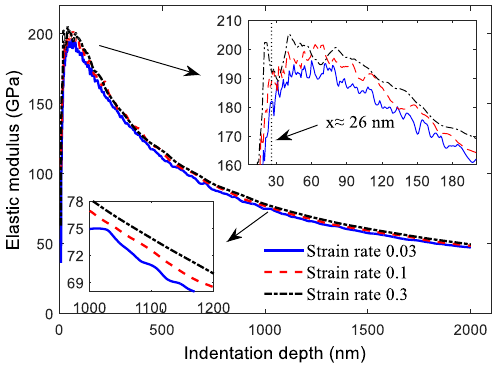
Figure 4. Elastic modulus vs. the depth for the three strain rates of 0.03, 0.1, and 0.3 s −1 .